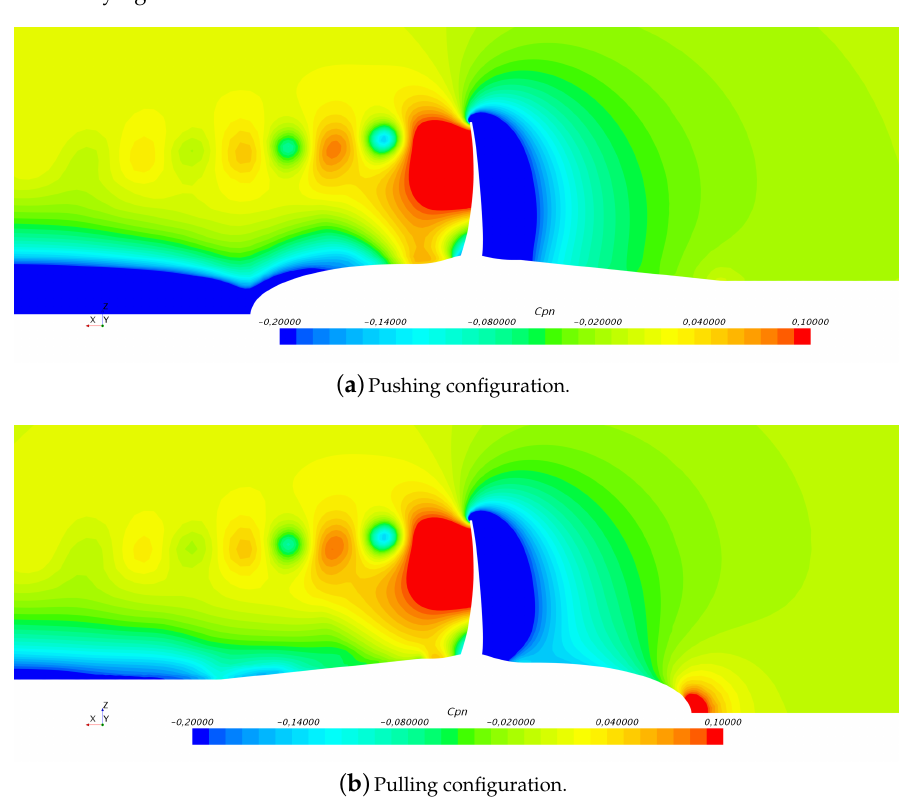
Figure 7. Shaft direction effect on pressure field at J =